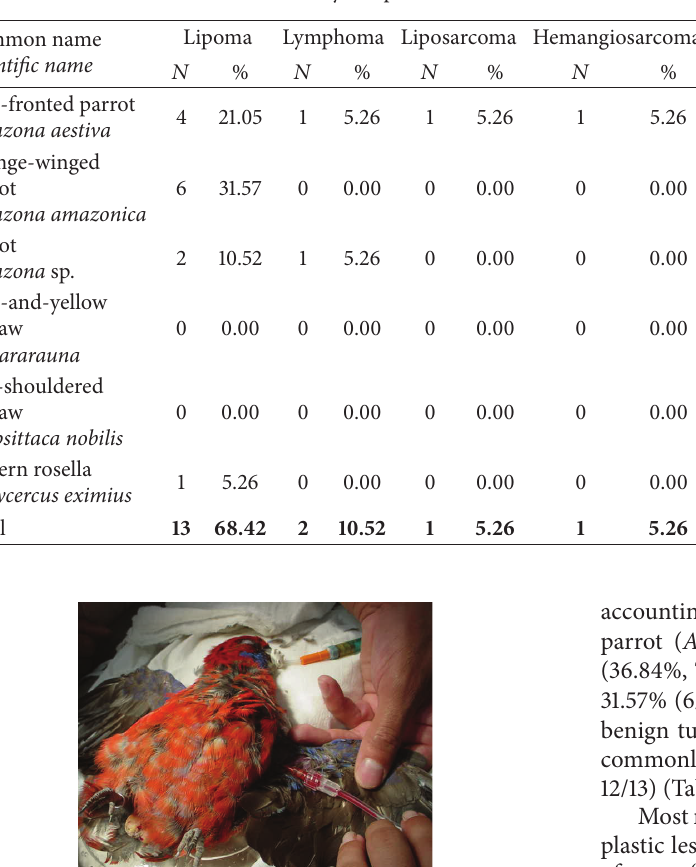
Table 1: Numerical ( 𝑁 ) and percentage (%) distribution of soft tissue neoplasms in different species of Psittaciformes submitted to surgical interventions at the FMVZ/USP Veterinary Hospital between 2000 and 2008, S˜ao Paulo, Brazil.